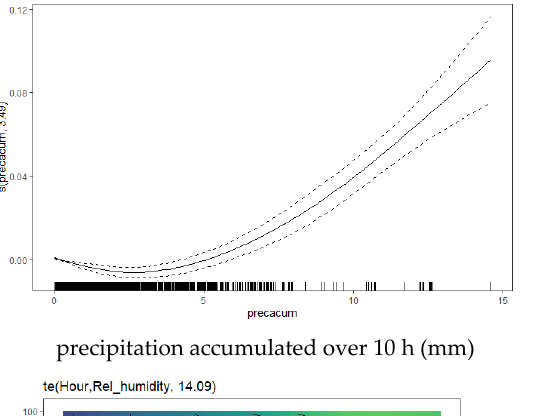
Figure 7. Explanatory variables that explain the variation of evaporation above cobble-stones and concrete slabs surfaces used in GAM model (2 and 3).